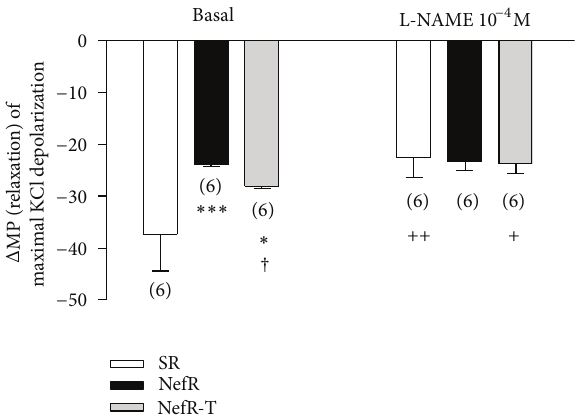
Figure 4: Membrane potential (MP) in unrubbed aortic rings from SR (white bars), NefR (black bars), and NefR-T (gray bars) in basal conditions (Krebs) and the effect of administration of L-NAME 10 −4 M. ∗∗∗ 𝑃 < 0.001 NefR basal versus SR basal; ∗ 𝑃 < 0.05 NefR- T basal versus SR basal; ++ SR L-NAME 𝑃 < 0.01 versus SR basal; + 𝑃 < 0.05 NefR-T L-NAME versus NefR-T basal; † 𝑃 < 0.05 NefR- T basal versus NefR basal. Two way ANOVA. Data are expressed as mean ± standard error. The number of rings is given in